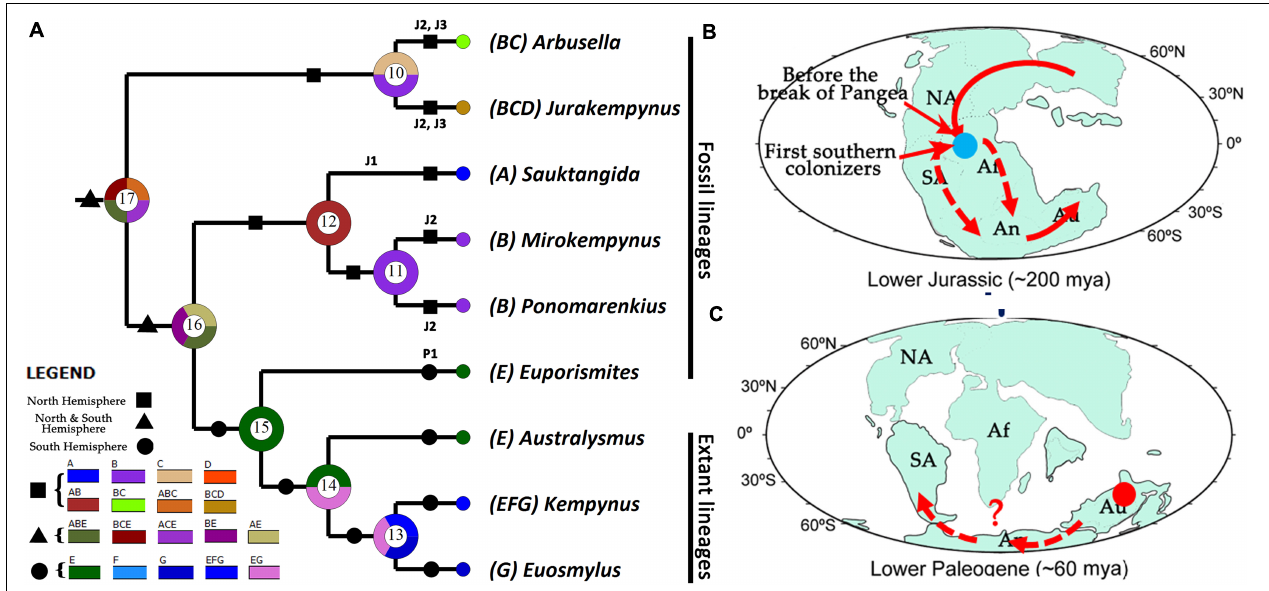
FIGURE 3 | Ancestral distribution reconstruction and putative dispersal routes of Kempyninae. (A) Ancestral distribution reconstruction of kempynine genera from DIVA analysis (A, Sauk-Tanga of early Jurassic, Kyrgyzstan; B, Daohugou of middle Jurassic, China; C, Karatau of later Jurassic, Kazakhstan; D, Shar-Teg of late Jurassic, Mongolia; E, Australia; F, South America; G, New Zealand). (B,C) Hypothesized historical dispersal routes of kempynine ancestors (NA, North America; SA, South America; Af, Africa; An, Antarctica; Au,